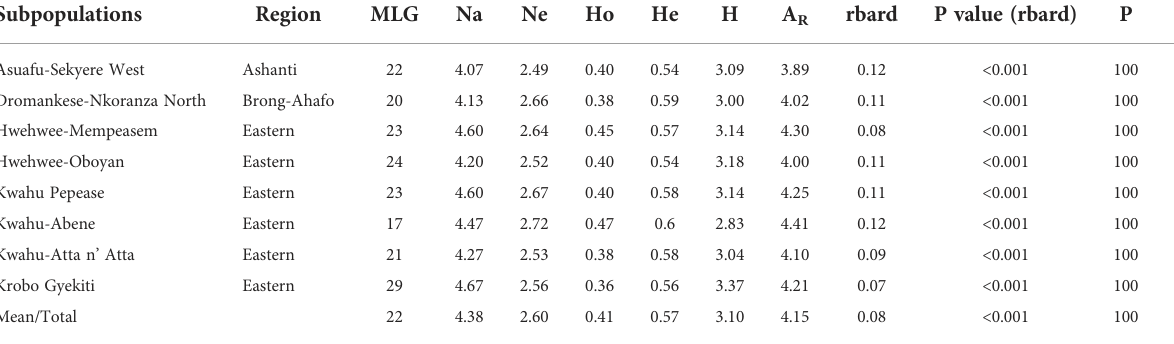
TABLE 3 Genetic diversity estimates for sampled Cryptolepis sanguinolenta individuals averaged across eight subpopulations and 15 microsatellite loci.